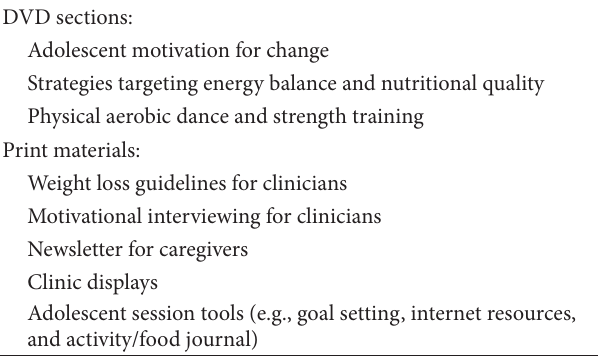
Table 1: General content of clinician toolkit used as a “menu of options” during clinical encounters with